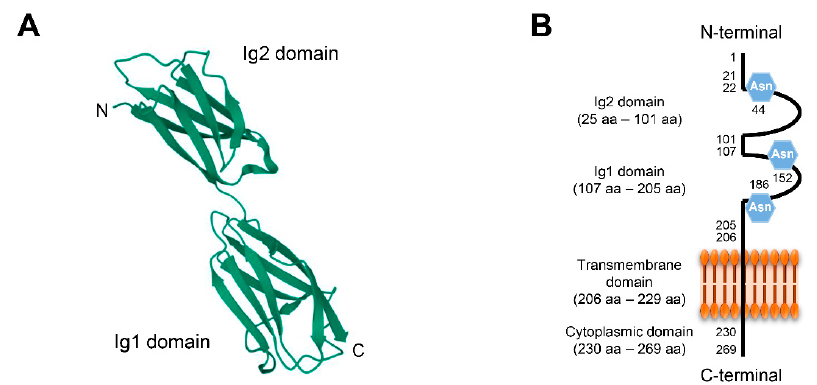
Figure 2. Structure of CD147. ( A ) Structure of extracellular Ig domains of CD147. ( B ) One monomer of CD147 is 269 amino acids (aa) in length and consists of two extracellular Ig domains, Ig1 and Ig2, a single transmembrane domain, and a short cytoplasmic domain. The extracellular region of CD147 contains three asparagine (Asn) glycosylation sites.